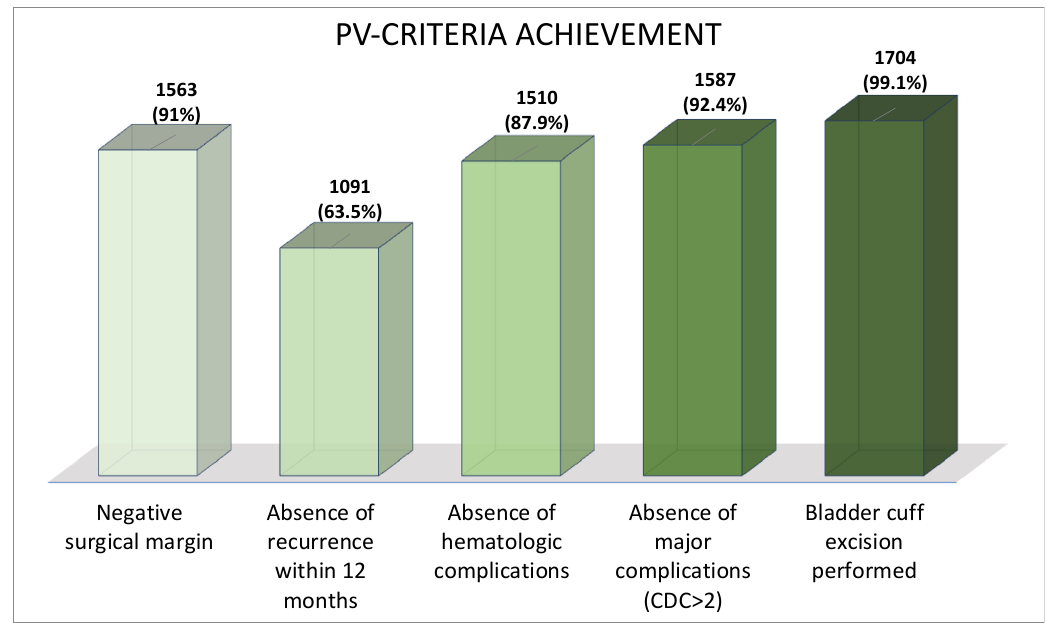
Figure 1. The proportion that achieved each pentafecta criterion in the 1718 patients treated with RNU for high-risk UTUC. CDC = Clavien–Dindo Classification.